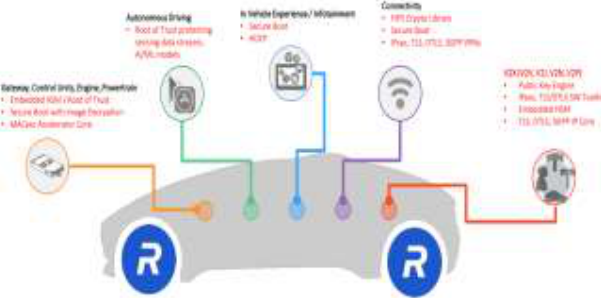
Figure 6. © Vehicle security vulnerabilities possible Copyright 2022,